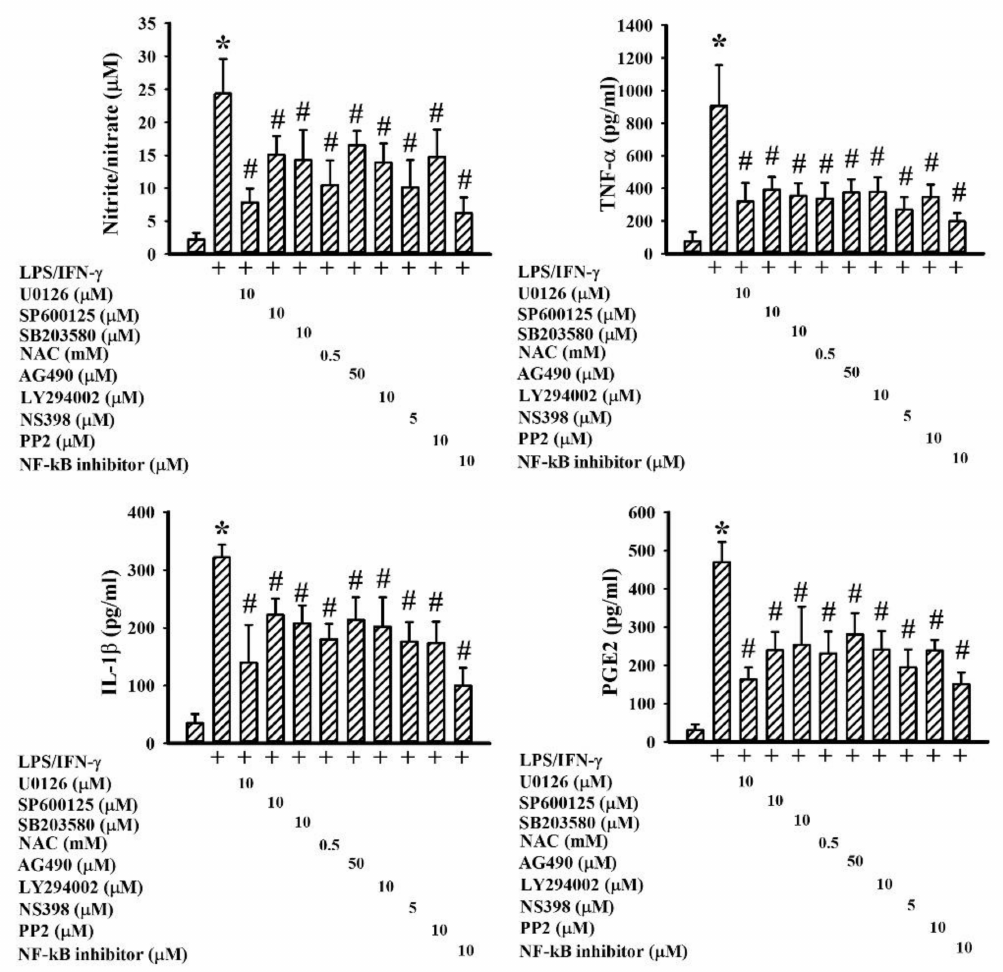
Figure 10. Pharmacological inhibitors alleviated inflammatory mediator production.